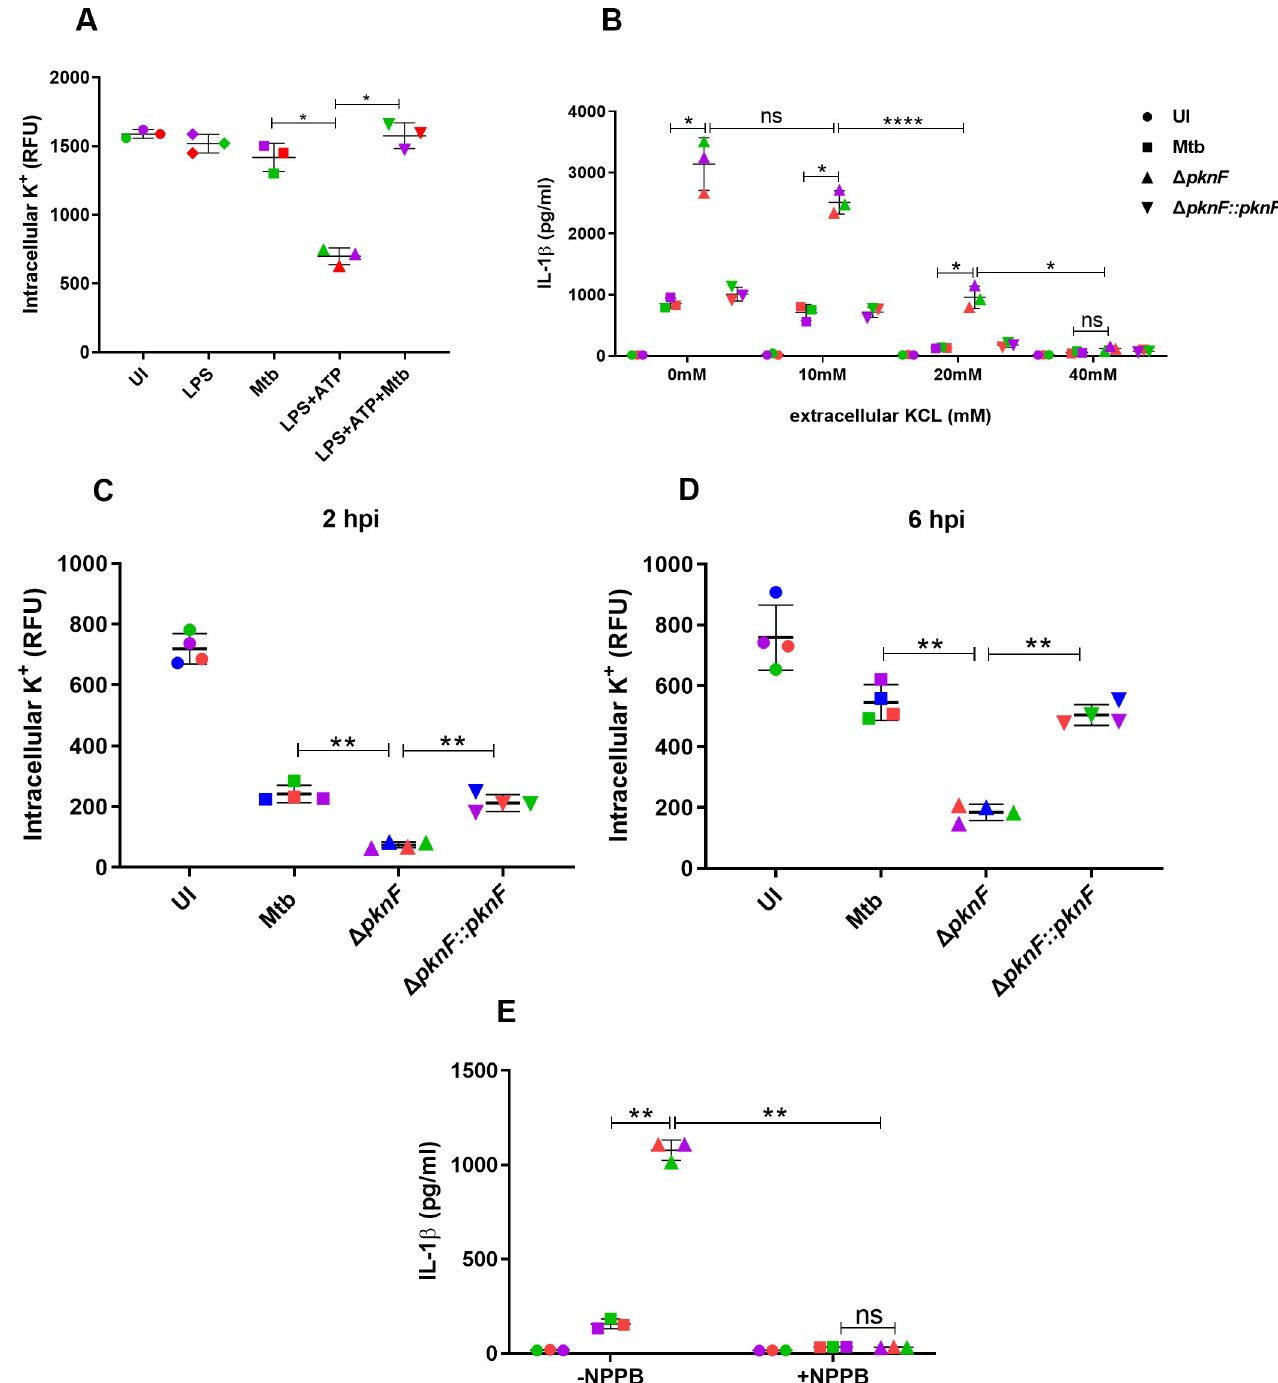
Fig 6. Potassium and chloride efflux are essential triggers for NLRP3 inflammasome activation in pknF Mtb mutant infected BMDMs. BMDMs were primed with LPS (100ng/ml, 4 h) followed by stimulation with NLRP3 activator, ATP (0.1mM, 30 min), when indicated, cells were infected with CDC1551 Mtb before stimulation with ATP. Uninfected cells, LPS treatment alone and Mtb infection alone were used as controls in the experiment. After 30 min of ATP stimulation (A) intracellular levels of K + was measured by the FluxOR II green potassium ion channel assay. BMDMs were either left untreated (0 mM) or treated with increasing concentrations of extracellular KCL (10 mM, 20 mM and 40 mM) and then infected with different CDC1551 Mtb strains (Mtb, Δ pknF mutant and complement Δ pknF :: pknF ). Culture supernatants were harvested at 20 hpi and analyzed for (B) IL-1 β secretion by ELISA. BMDMs were either left uninfected (UI) or infected with different Mtb strains (Mtb, Δ pknF mutant and complement Δ pknF :: pknF ) at an MOI of 10 for 4h and intracellular K + concentration was measured at (C) 2 hpi and (D) 6 hpi by FluxOR II green potassium ion channel assay. BMDMs were either left untreated (-NPPB) or treated